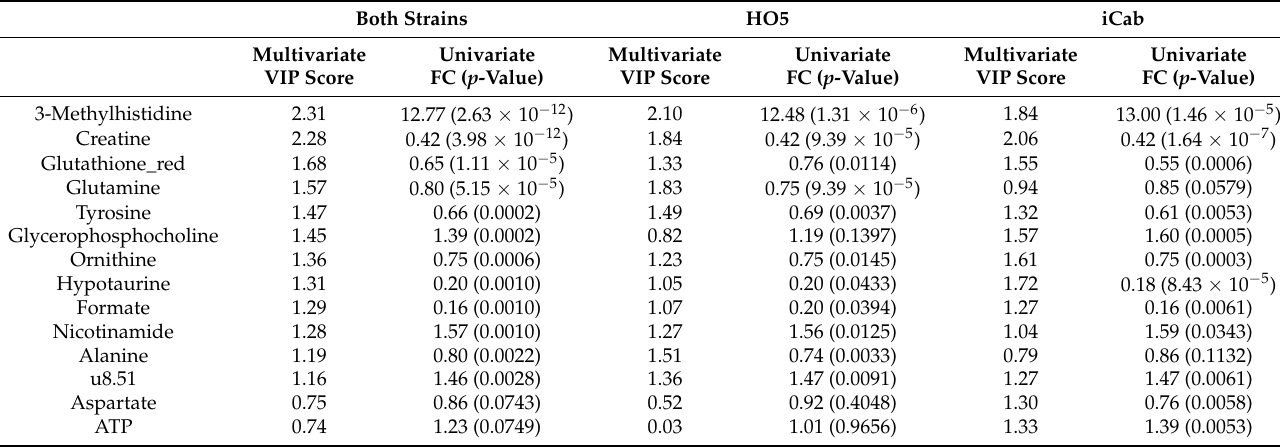
Table 2. Top 14 metabolites contributing to the variance between male and female fish according to PLS-DA and FC analysis. Analyses were performed separately for HO5 and iCab fish, as well as with both strains together. Only metabolite buckets are shown that had VIP values > 1.2 and FC > 1.3 or <0.77 for at least one of the different groups. For each FC, the associated FDR-adjusted p -value is